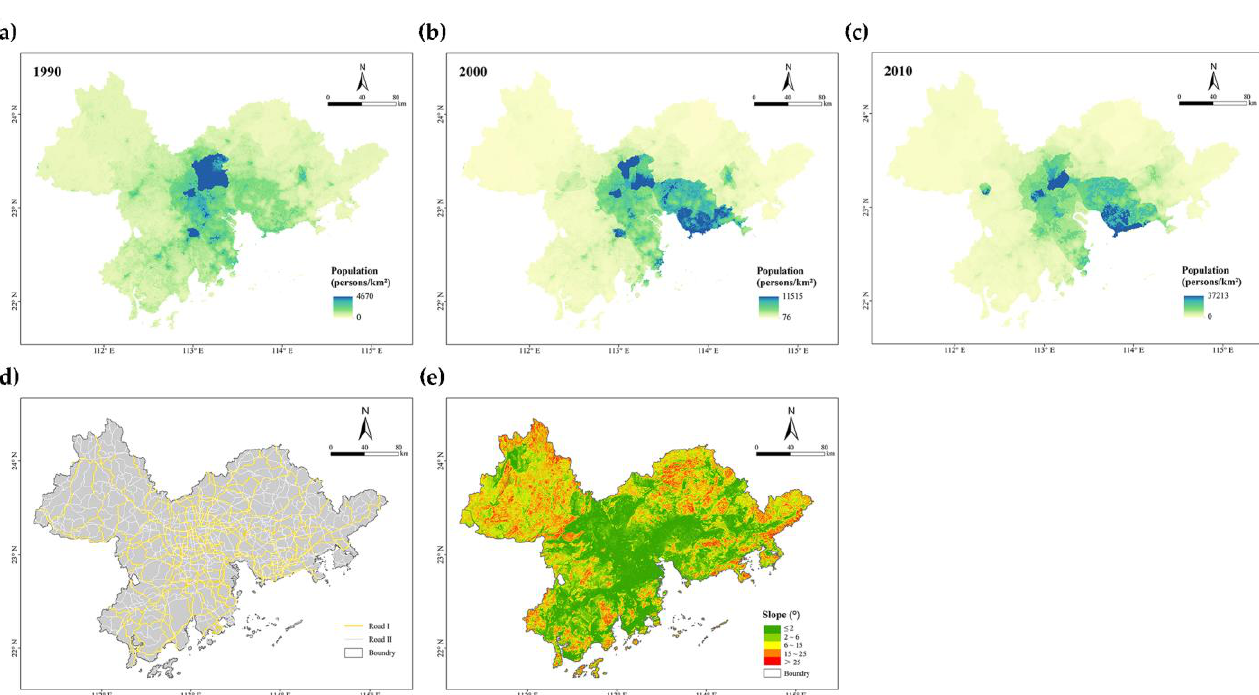
Figure 3. Spatial distribution of population in the GBA from 1990 to 2010 ( a – c ), distribution of road networks in two different periods ( d ) (Road I and II represent the roads in 1980–2000 and 2000–2020, respectively), spatial distribution map of slope in the GBA ( e